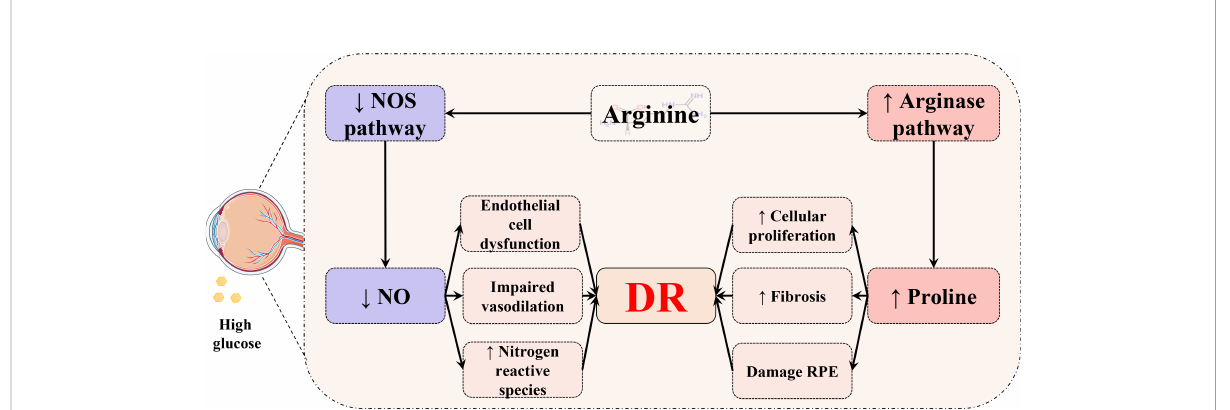
FIGURE 11 Schematic diagram of the relationship between the arginine – proline metabolism pathway and DR. In the retina, arginine is metabolized through two distinct pathways. The diabetic status could cause increased proline to damage the retinal pigment epithelium (RPE) and induce cellular proliferation and fi brosis. Meanwhile, hyperglycemia may lead to a de fi ciency of NO and result in consequential endothelial cell dysfunction, impaired vasodilation, and an increased level of oxygen and nitrogen reactive